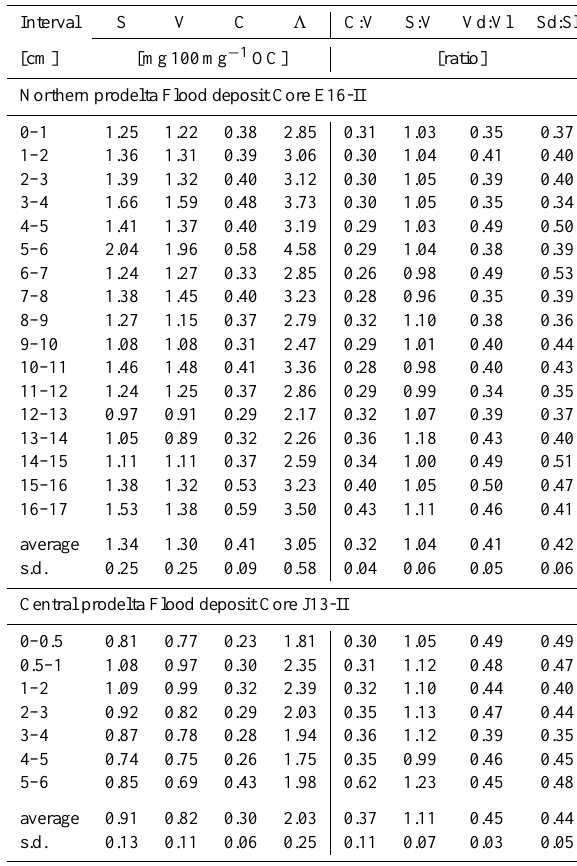
Table 6. Bulk compositions for sediment cores collected in the Po prodelta. See Fig. 1 for core locations.